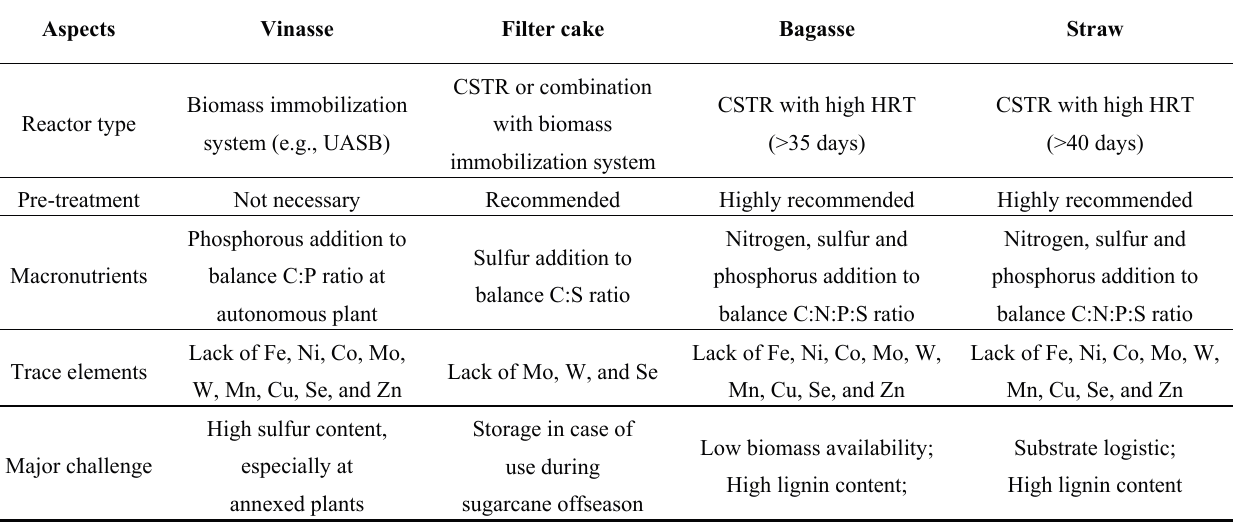
Table 6. Summary of the kinetic challenges for designing an anaerobic digestion process applied to the sugarcane